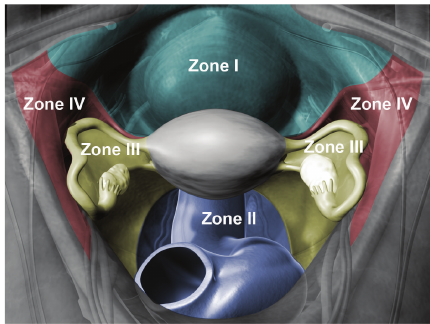
Figure 1: A color-coded illustration of the anatomical boundaries and the contents of all pelvic